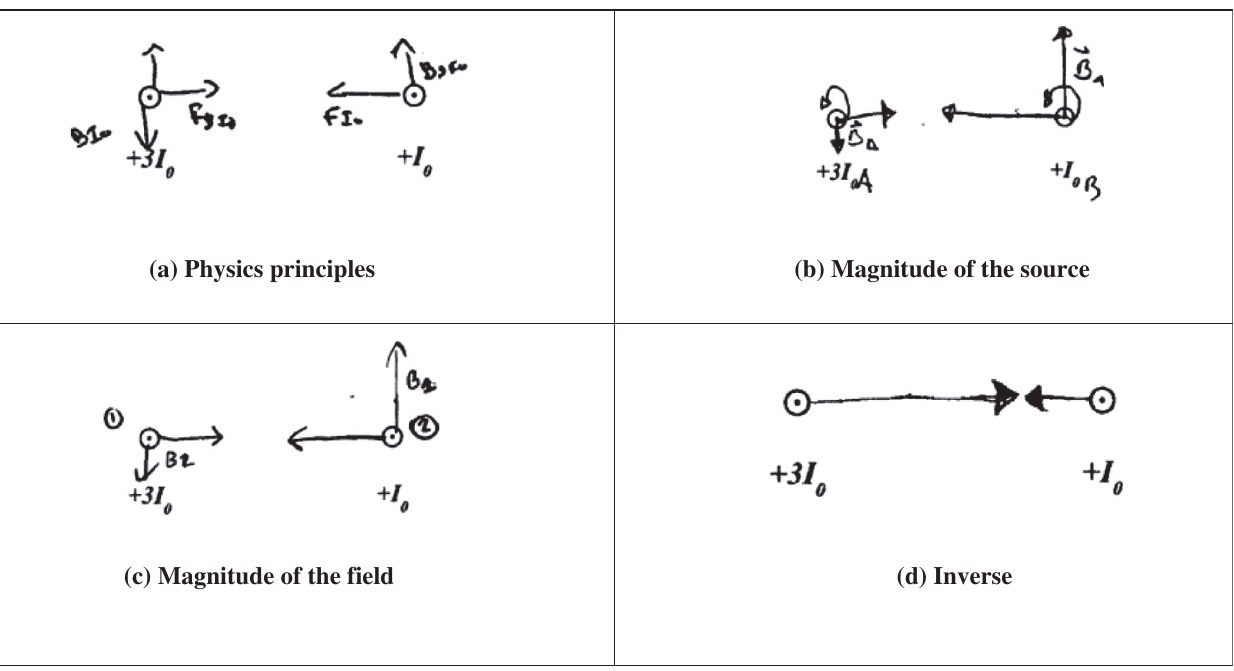
FIG. 12. Student example diagrams for each category of item 3 in the magnetism